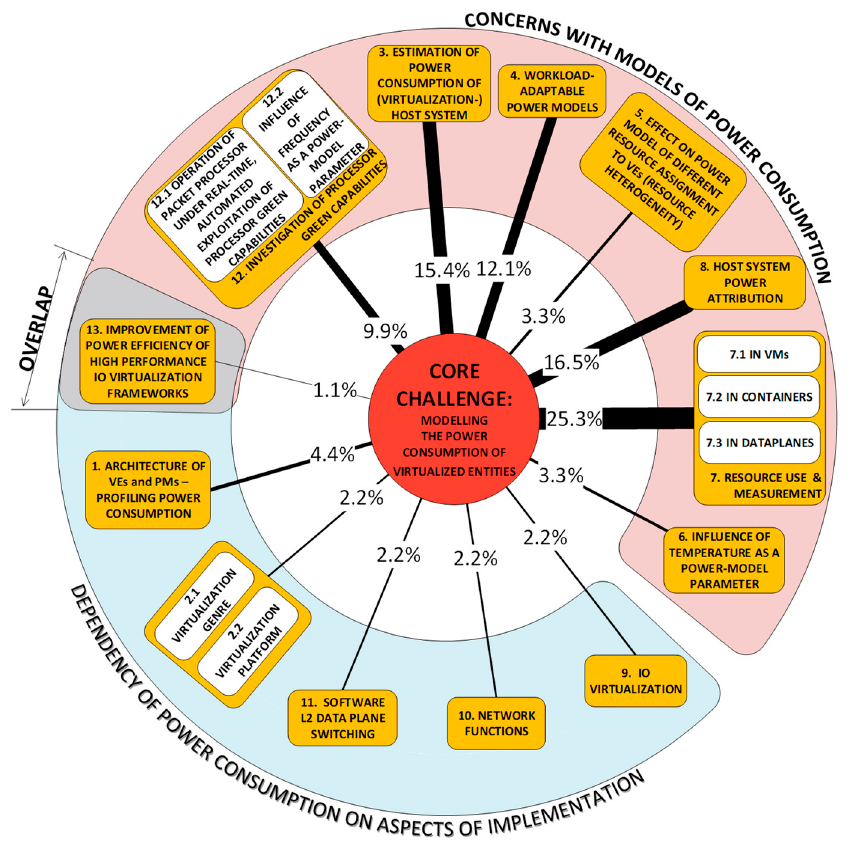
Figure 1. The core challenge and its derivatives; research interest R P (cid:2900) as and as percentage.